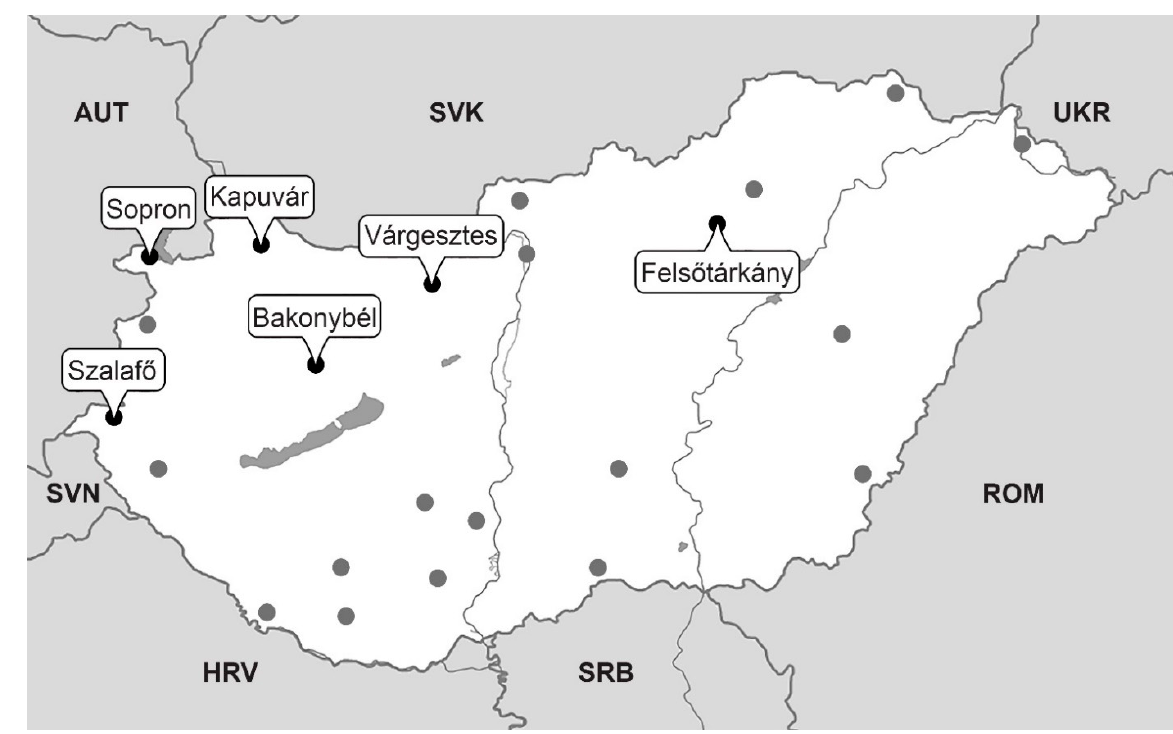
Figure 1. The locations of the light traps included our analysis (black dots and names of nearest settlements). Grey dots show the locations of working light traps not included in our current analysis. Table 1. Location information, time period and numbers of Lepidoptera included in the analysis from the 6 light traps involved in the study, arranged from east to west by location.